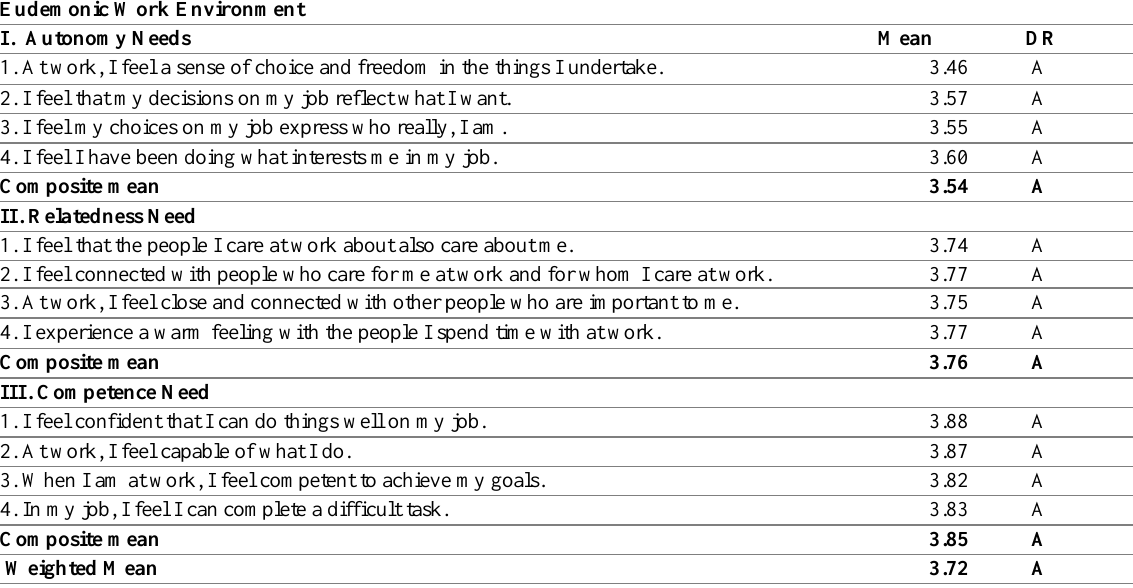
Table 7: Workplace Environment as to Eudemonic Work